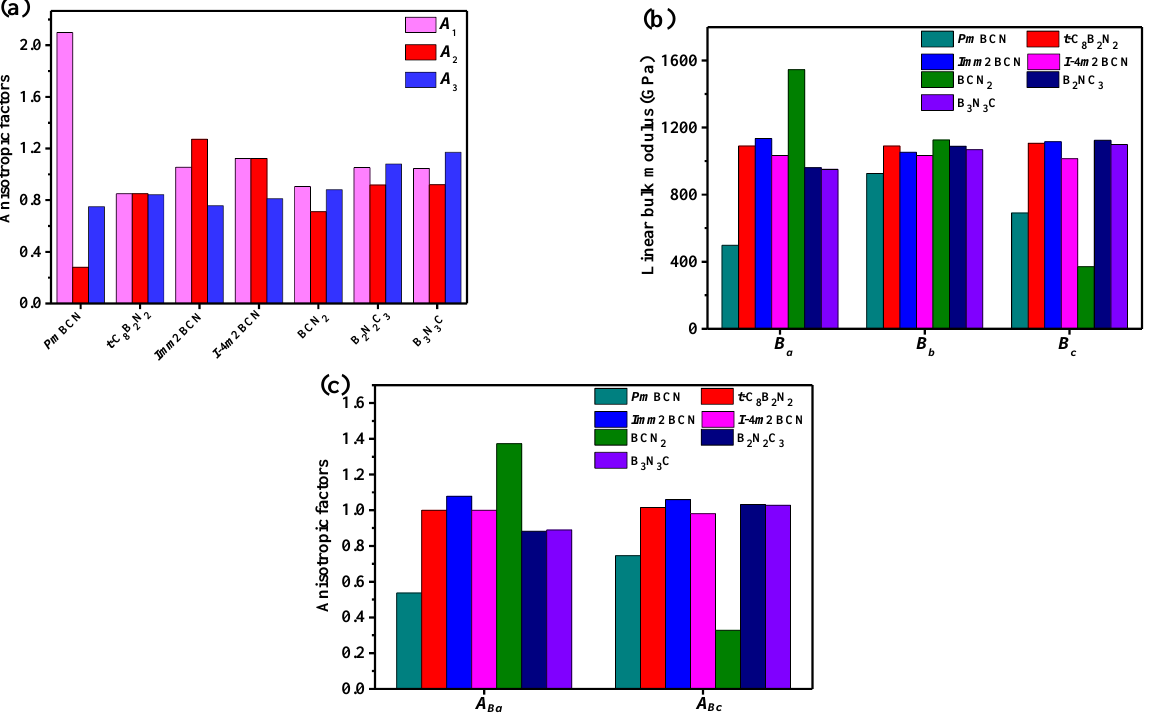
Figure 4. Anisotropy factor A 1 , A 2 , and A 3 ( a ); linear bulk modulus B a , B b , and B c ( b ); A Ba and A Bc ( c ) for Pm -BCN.